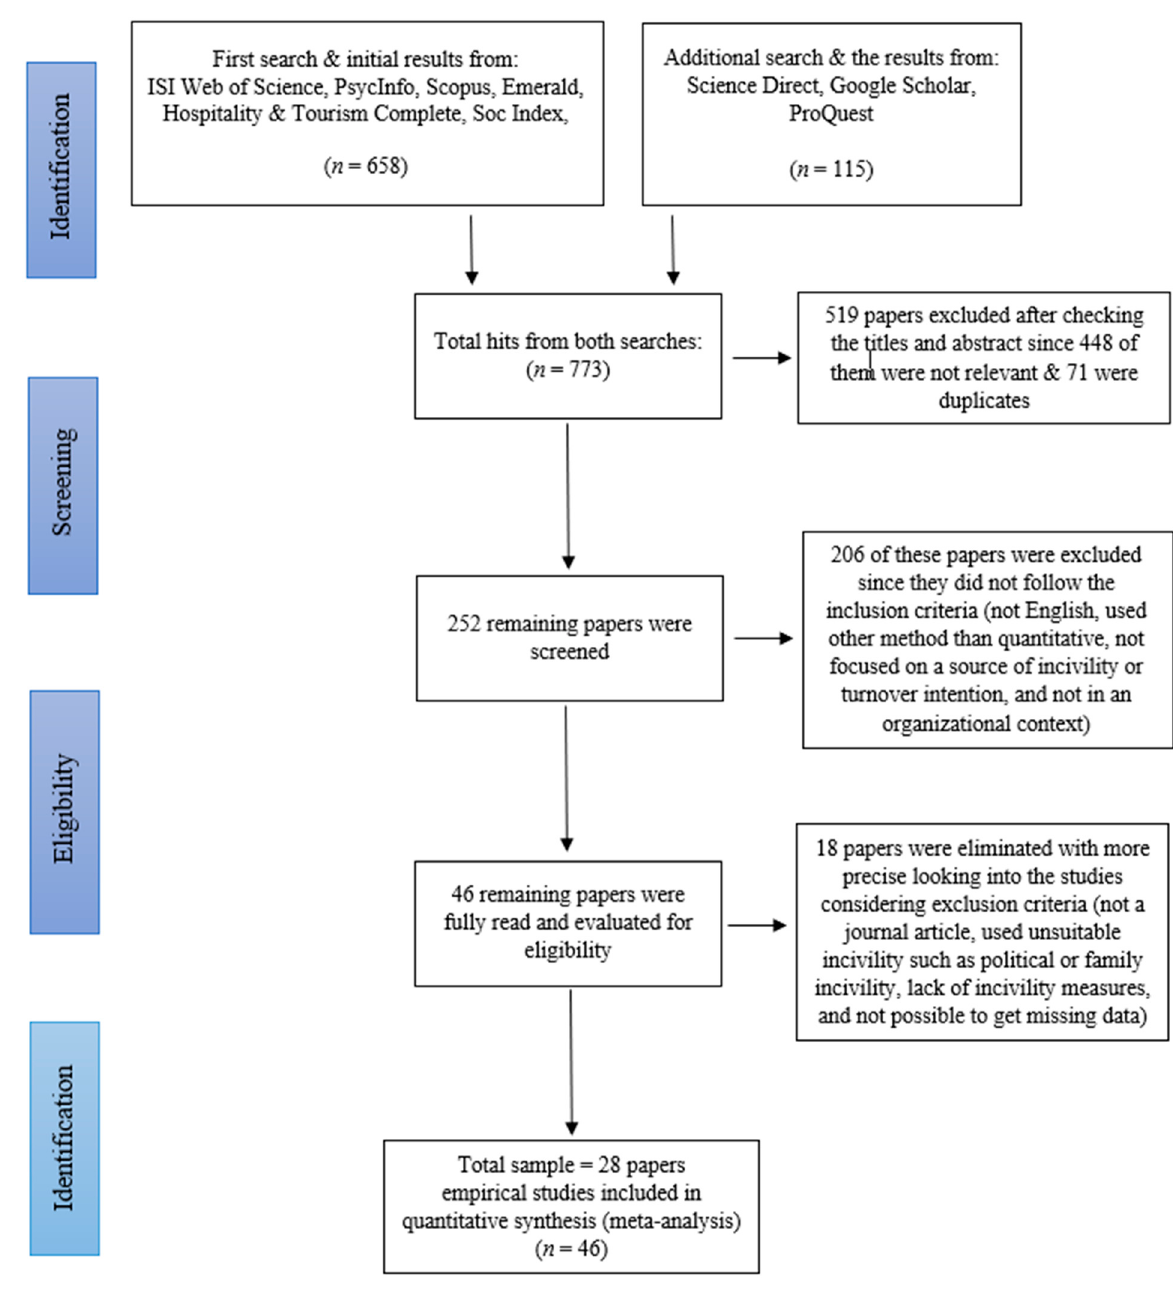
Figure 1. PRISMA 2009 flow chart.